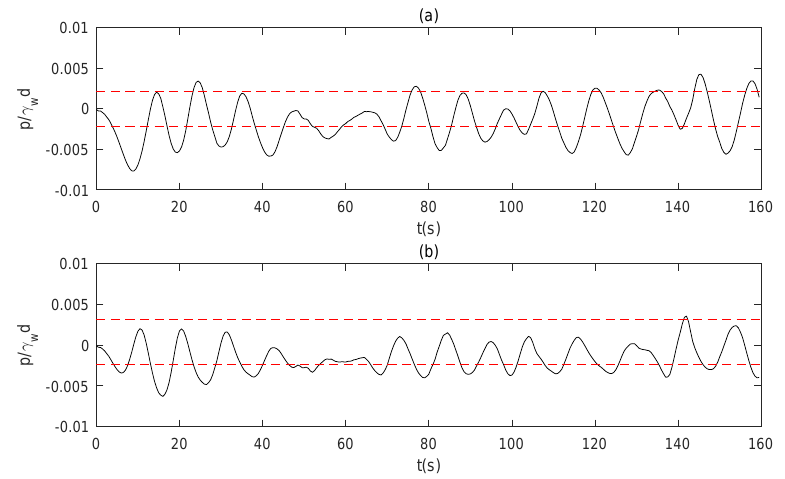
Figure 19. Time-varying normalized pore pressure distribution at two levels by using JONSWAP spectrum. ( a ) z = − 0.5 h and ( b ) z = − h